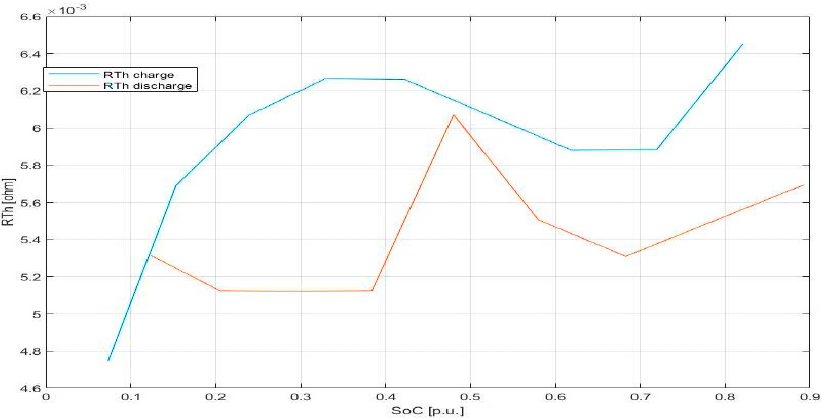
Figure 10. R th at different values of SoC.